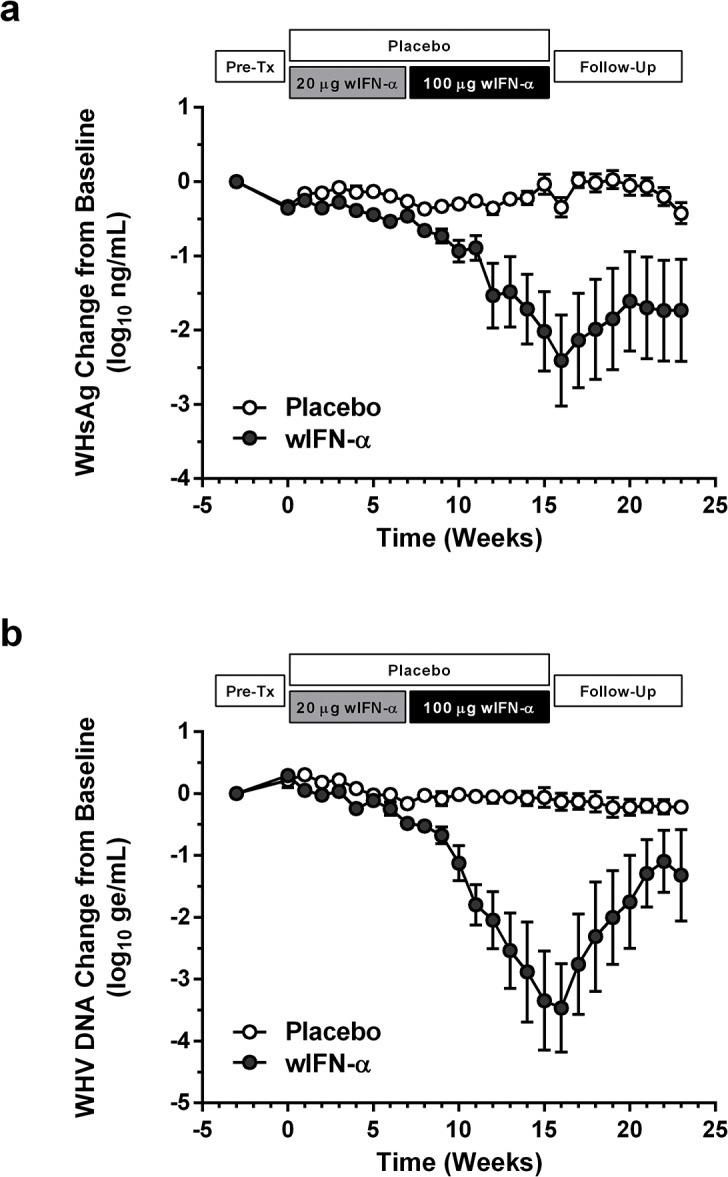
wIFN-α treatment of chronic WHV carriers induces suppression of serum antigenemia and viremia.Change in serum (a) WHsAg and (b) WHV DNA relative to week -3 (pre-treatment baseline). Circles indicate the mean of each group (open: placebo, closed: wIFN-α), and the error bars represent the standard error of the mean. The WHsAg level for two wIFN-treated animals was ≤ lower limit of detection (LLOD; 20 ng/mL) at various times during the study (S2 Fig); the LLOD was used to estimate the WHsAg decline at these timepoints. Note that seven animals (three in the placebo group, four in the wIFN-α group) died during the study, and one animal in the wIFN-α group (M1004) was excluded from the analysis since it was likely naturally clearing WHV as the study initiated (see Table 1).